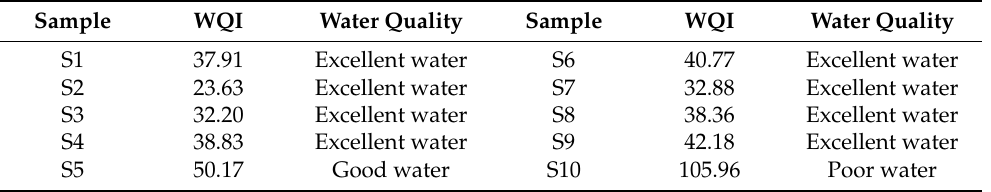
Table 5. Water quality index values and water types in the study area.